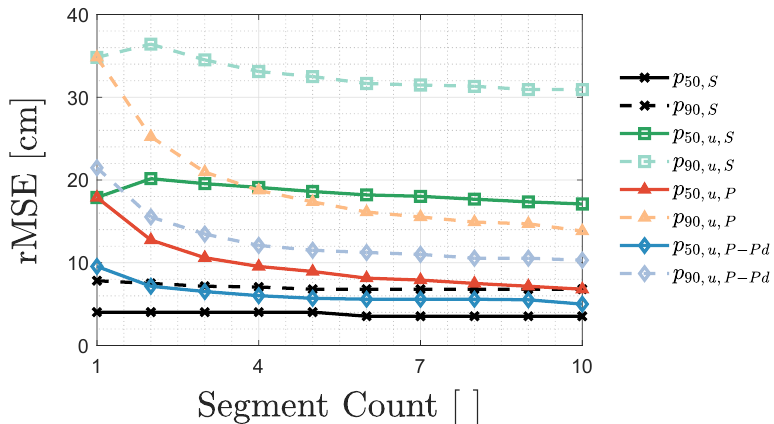
Figure 12. Influence on the p 50 and p 90 of MBFB-based VLP S, uVLP S, uVLP P and uVLP P-Pd of averaging the segments’ I PD , i